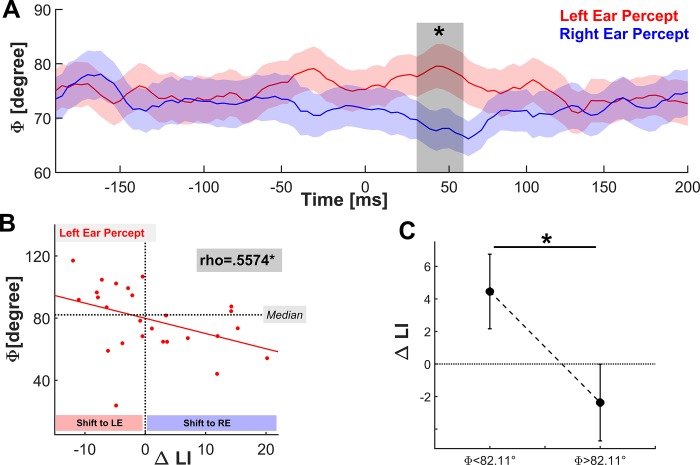
Oscillatory key signature of the interhemispheric phase lag.(A) Time course of the interhemispheric phase difference at 40Hz between the left and right BA42 averaged across all subjects (M±SEM) during sham-tACS. The shaded bar highlights the interval (36-56ms) where the phase shifts were statistically different between conditions (paired-sample permutation test with 10000 permutations, 'tmax'-method, *p < .05). (B) Circular-linear correlation between the individual phase shifts during auditory processing through the left ear in the cluster-corrected time window (36-56ms) and the behavioral outcome of the 180° stimulation at 40Hz (ΔLI = LIVerum—LISham). The significant correlation (rho = .557, p = 0.0176) indicates that tACS amplified the right ear advantage in subjects whose oscillatory asymmetry at 40Hz was smaller (closer to 0°) during conscious auditory processing. Contrary, augmented interhemispheric asymmetry (closer to 180°) was associated with a shift to left ear processing. (C) tACS-effect on behavioral performance after splitting the sample at the median angle (φ = 82.11°) into two equally sized subgroups (N = 13).